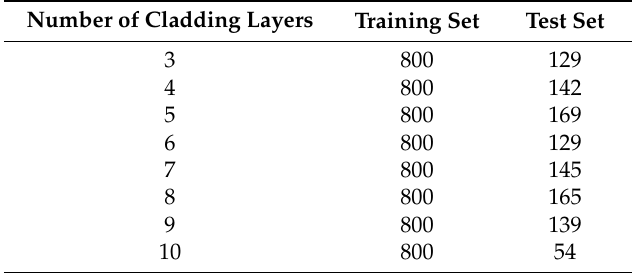
Table 3. Number of data groups within training and test sets.